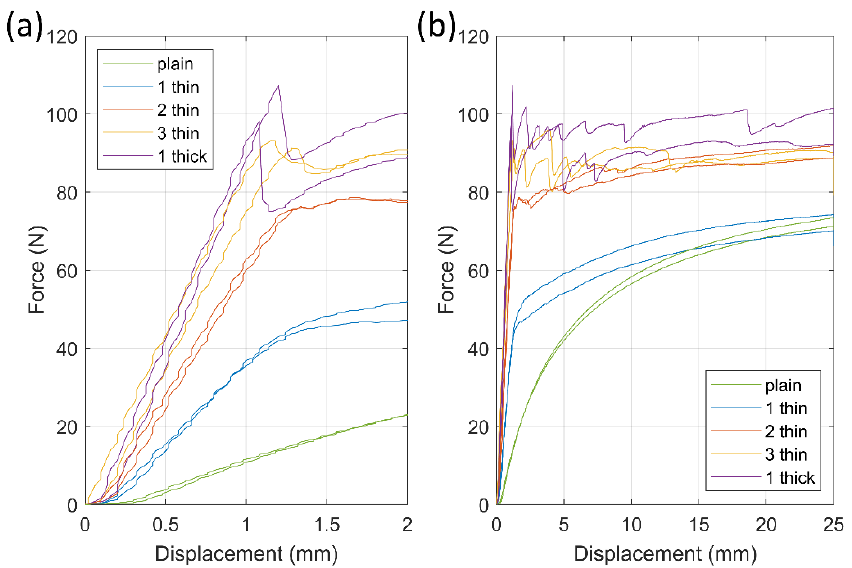
Figure 4. Force–displacement curves of the 3D-printed samples. ( a ) Results focusing on the initial 2 mm displacement (4% elongation), presenting the increase in stiffness caused by CFCs, ( b ) the samples’ total displacement was 25 mm (50% elongation).